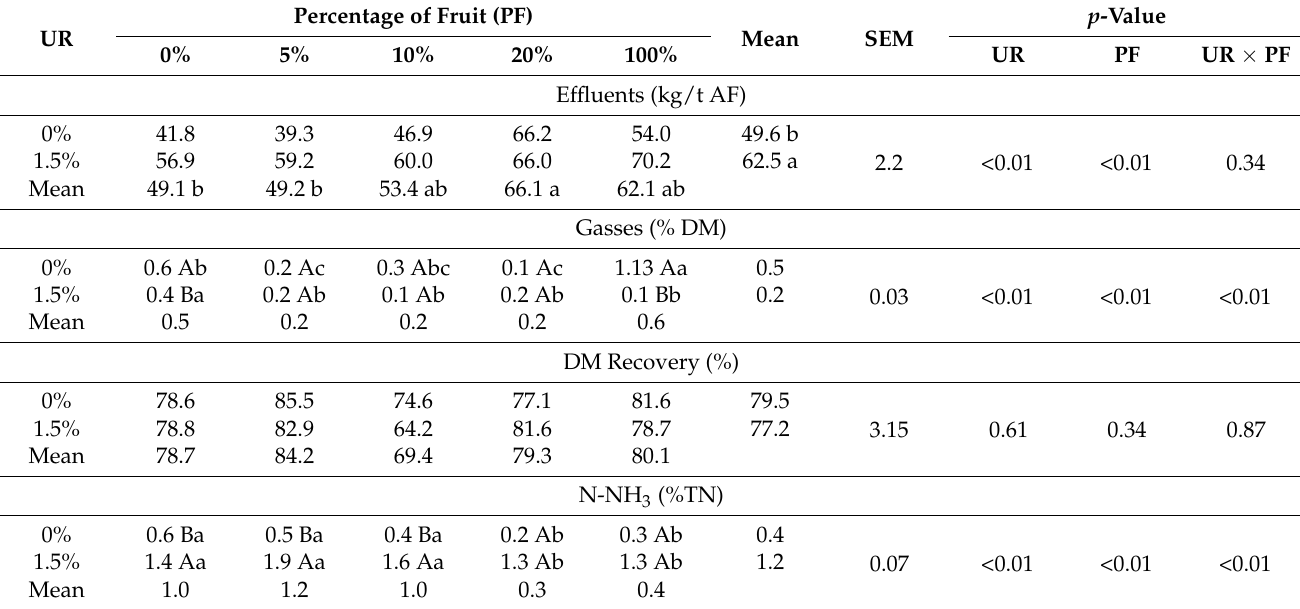
Table 4. Quantification of losses of silages with different mixtures of melon biomass and addition of urea.